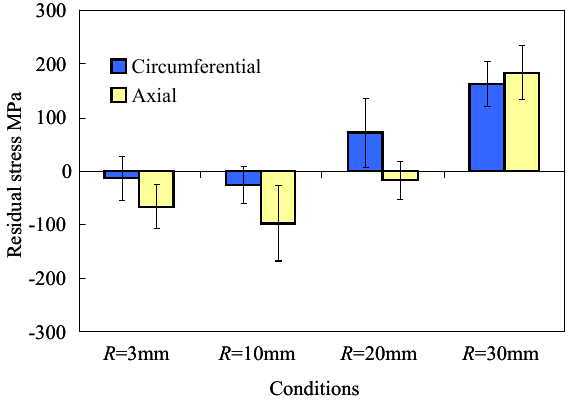
Figure 14. Residual stresses on processed surface.